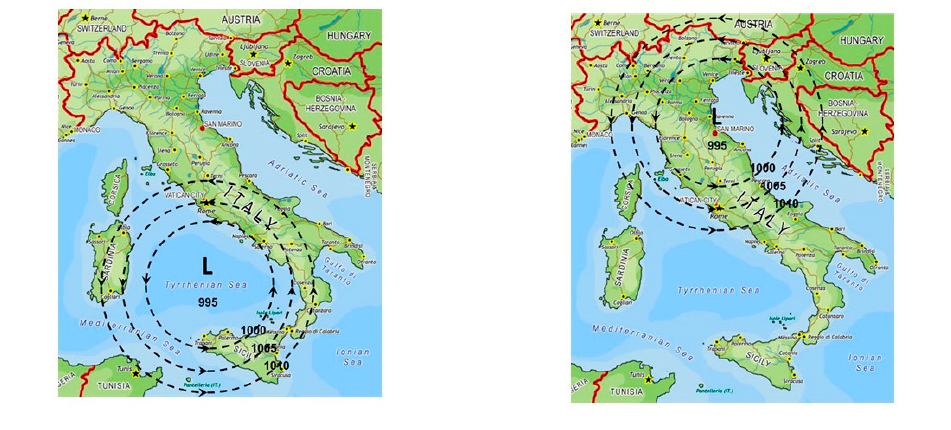
Figure 4. A schematic representation of a depression over some parts of Italy. In both cases the atmospheric pressure over Rome is identical (1005 hPa) however, prevailing flow are from different directions causing completely different weather conditions.